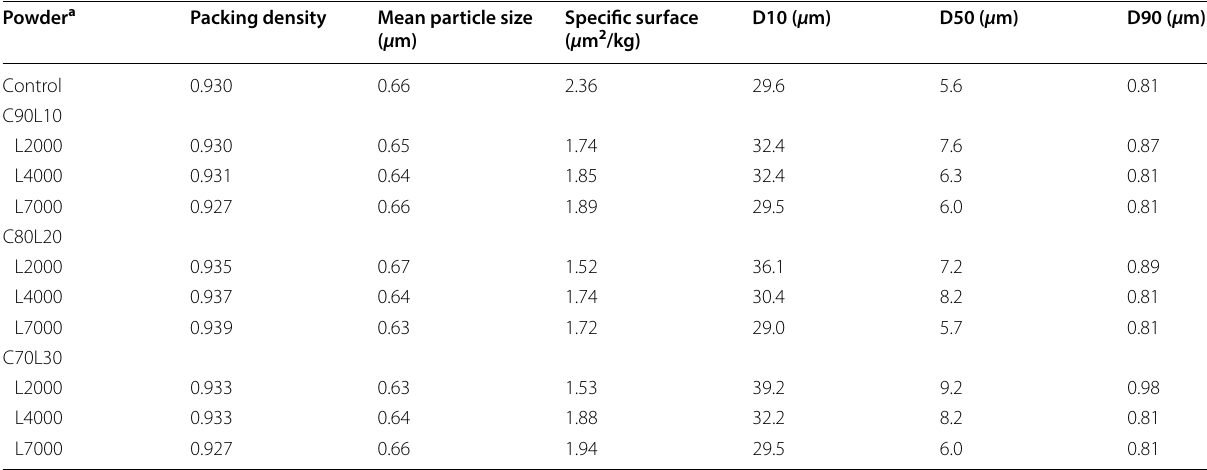
Table 4 The mixed powder conditions calculated.